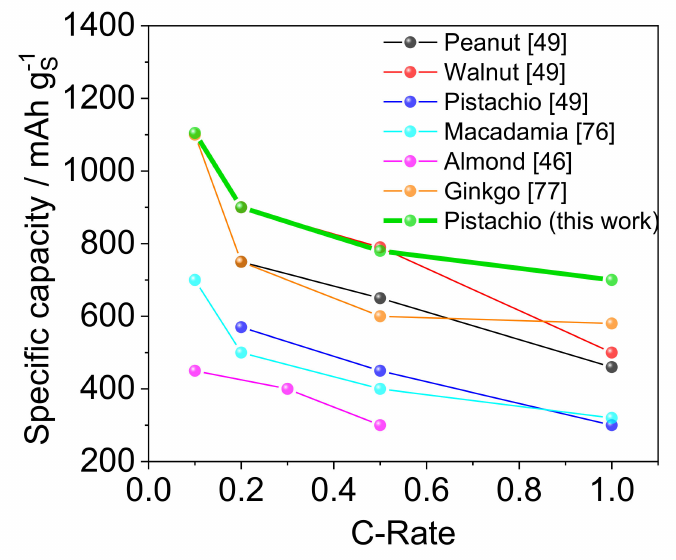
Figure 5. Variation in the specific discharge capacity reported in the literature as a function of the